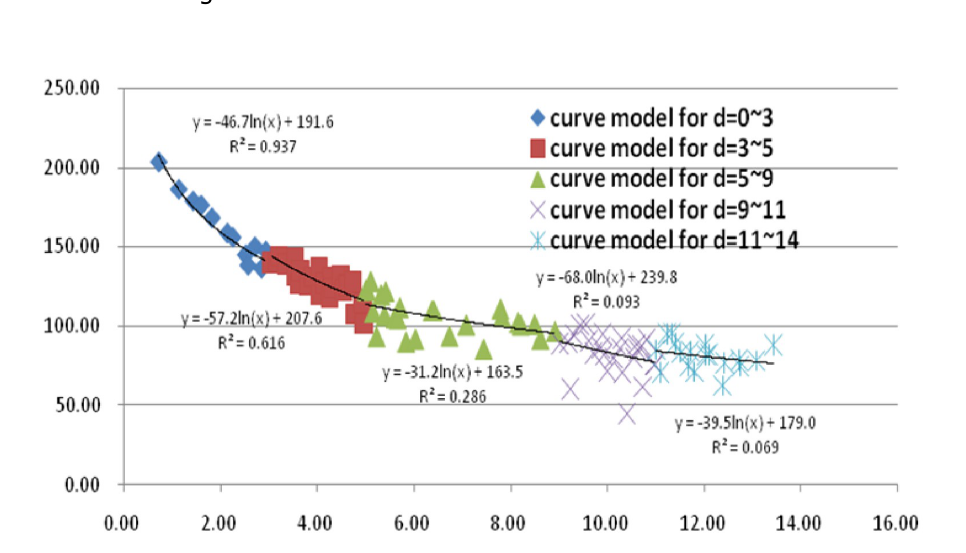
Figure 9. The fitting models of different distance ranges